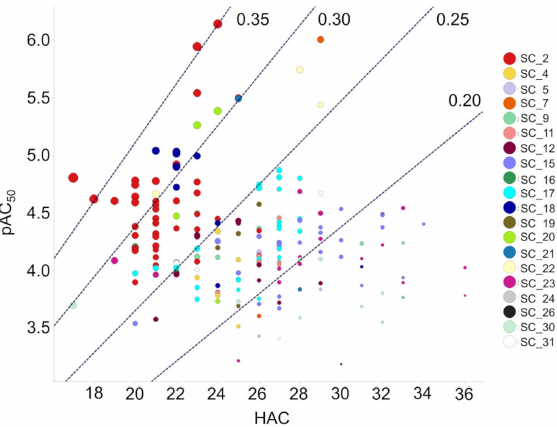
Figure 10. Scatter plot of pAC 50 versus HAC of the confirmed OXA-48 inhibitors colored by chemical classes. The size of the dots is related to the LE value series of compounds. Diagonal lines represent areas of LE values defined by the equation LE = (1.37/HAC) × pAC 50